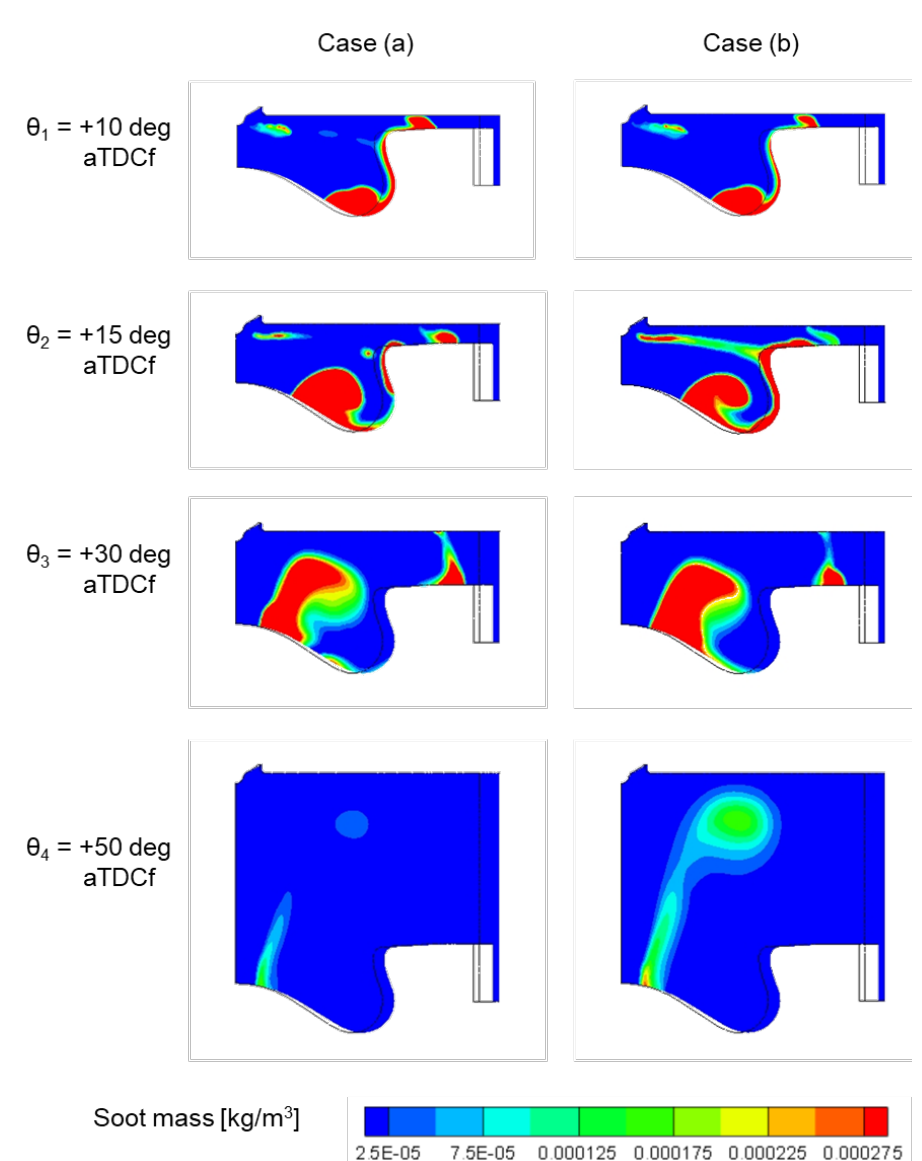
Figure 22. Contour plots of the soot mass distribution for the two chosen post injection schedules (case a and case b) at four different crank angle degrees.